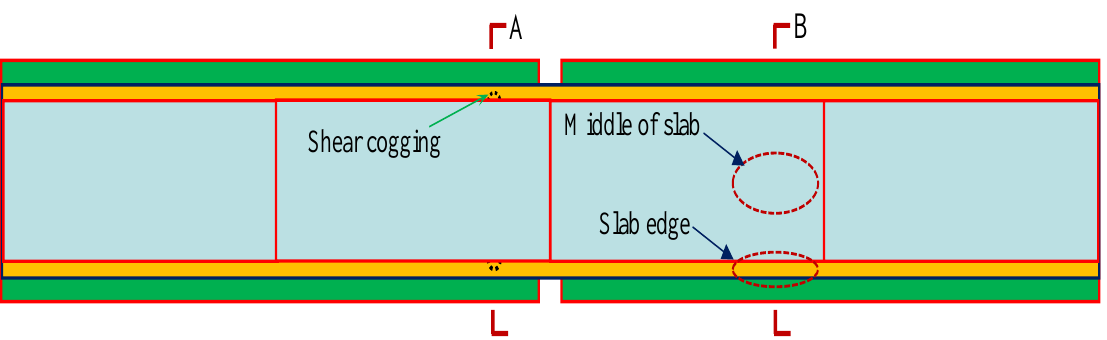
Figure 8. Planar graph of the ballastless track model.